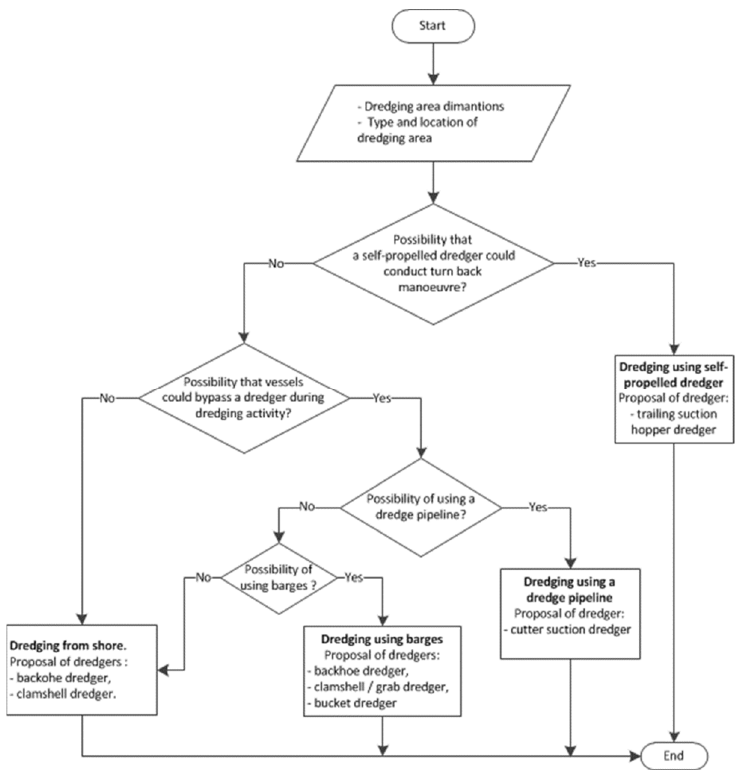
Figure 4. Algorithm for the selection of the dredging equipment according to the type and location of dredging work.